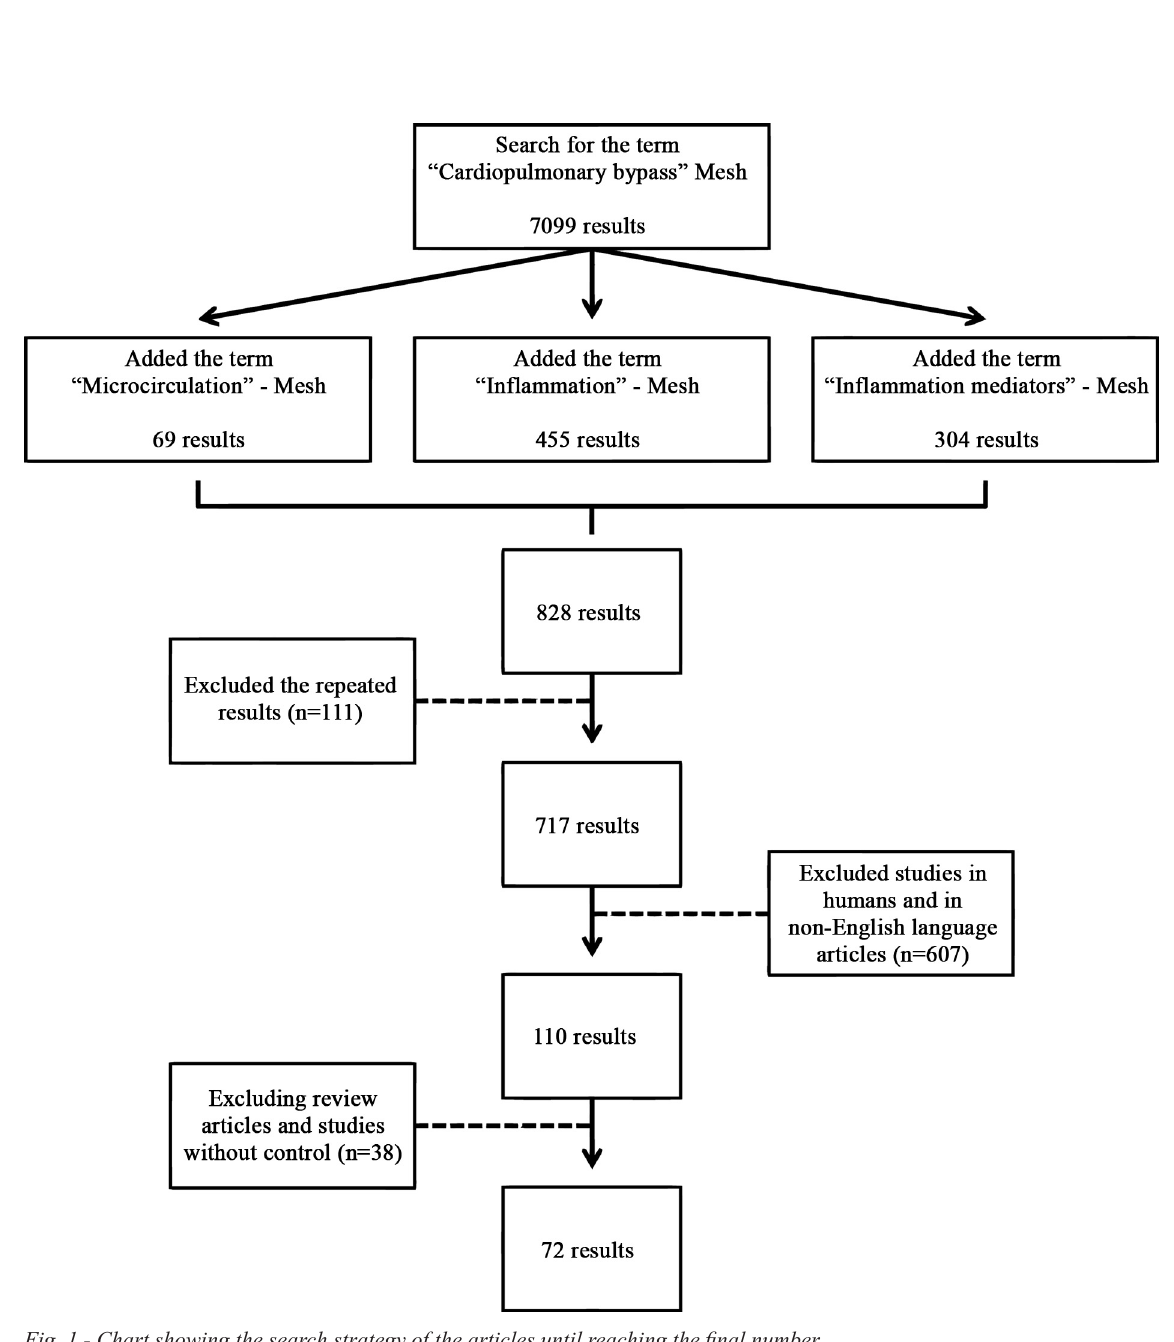
Fig. 1 - Chart showing the search strategy of the articles until reaching the final